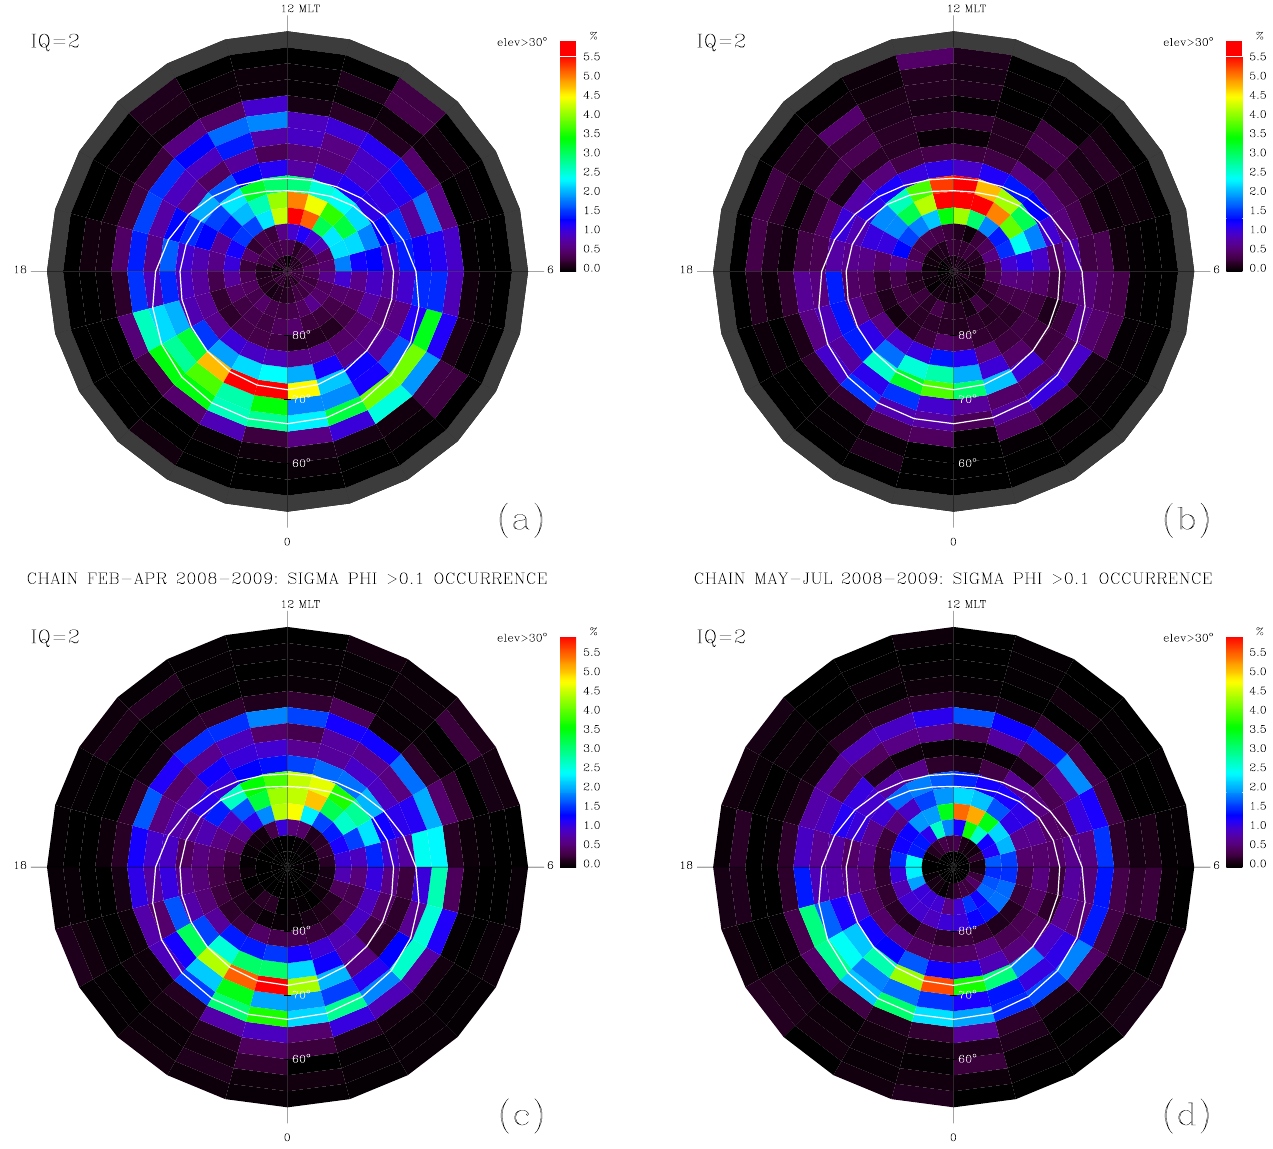
Fig. 6. Phase scintillation climatology maps for (a) autumn, (b) winter, (c) spring and (d) summer. Superposed in white line is the Feldstein oval for